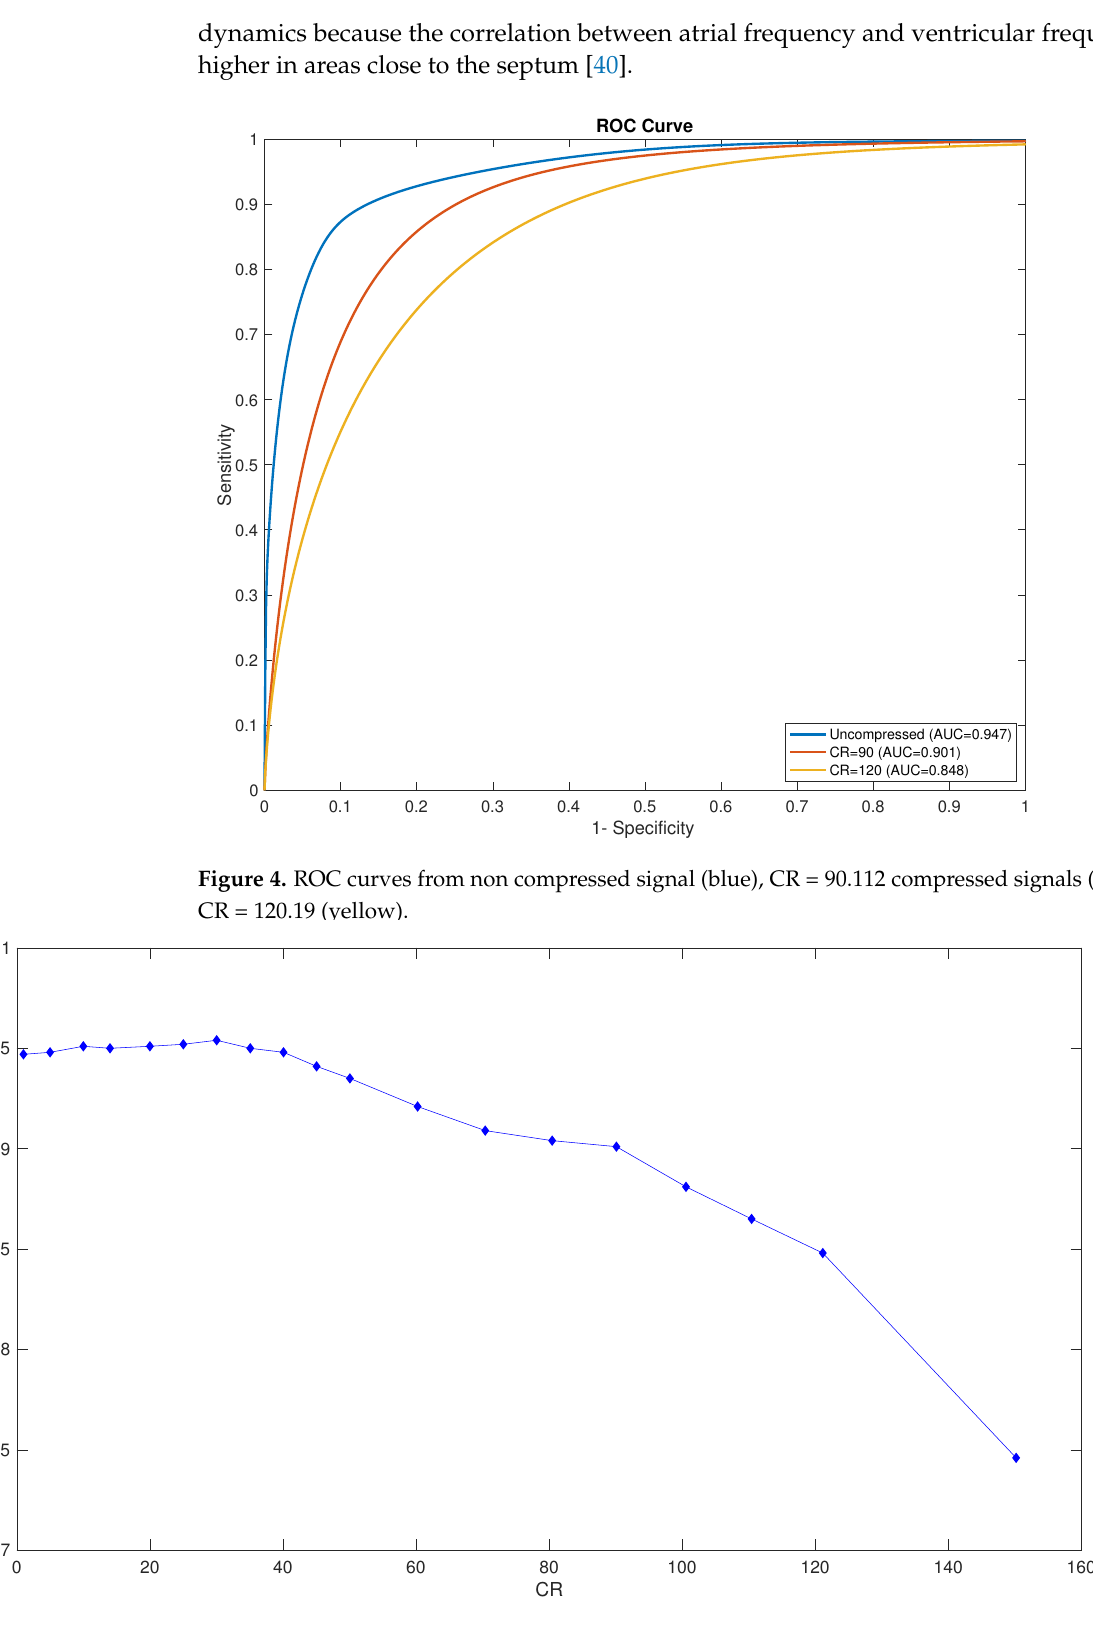
Figure 5. AUC versus CR, averaged over all records in the test